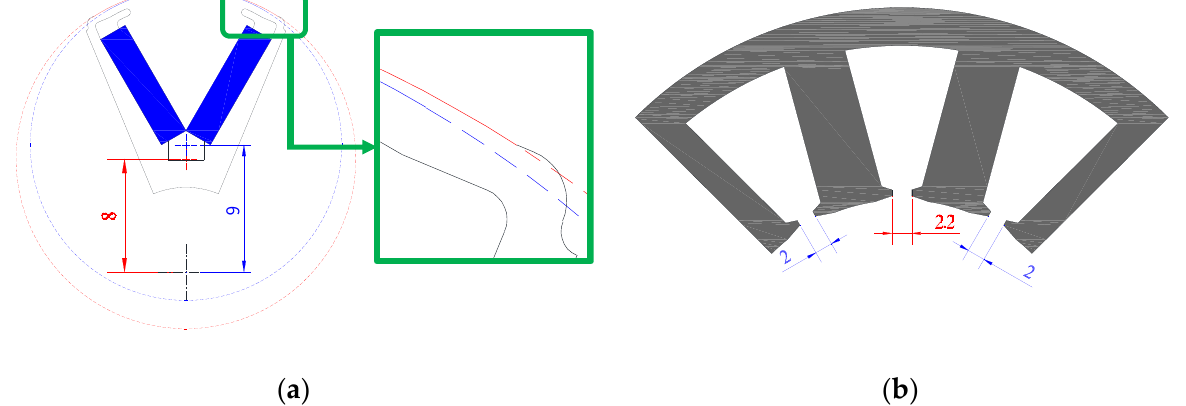
Figure 14. Allocation of the measured eccentricity and slot opening: ( a ) eccentricity; ( b ) slot open- ing.